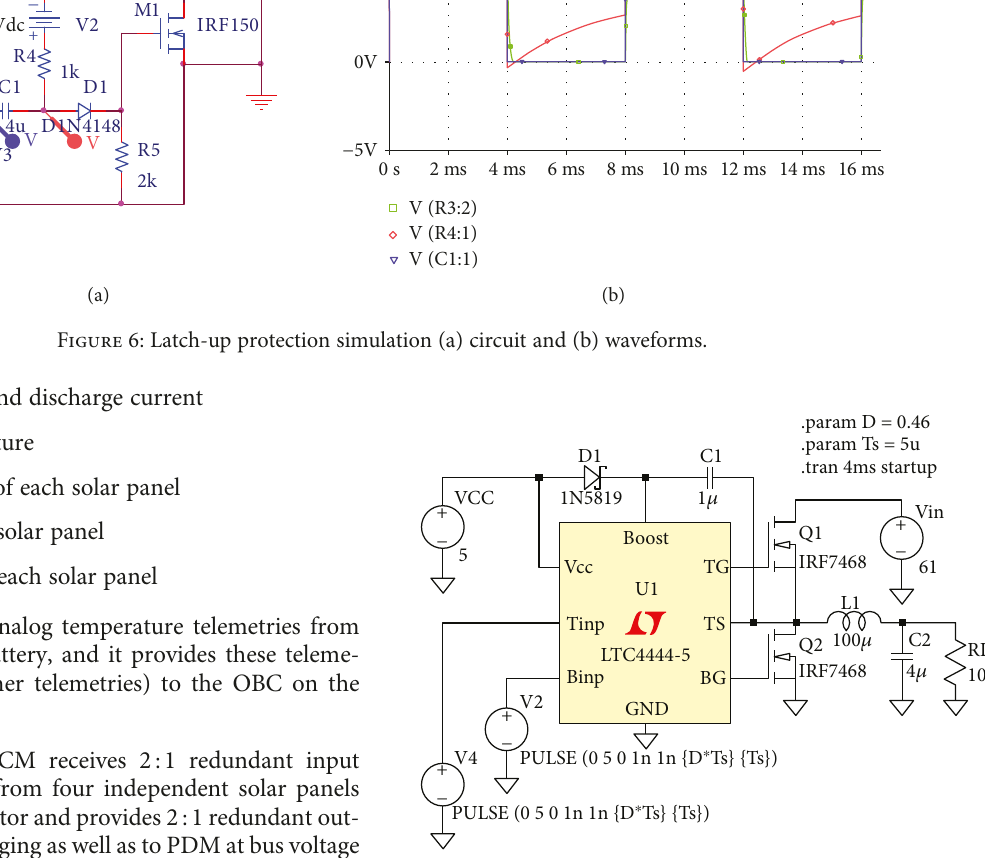
Figure 7: Simulation schematic of MPPT buck